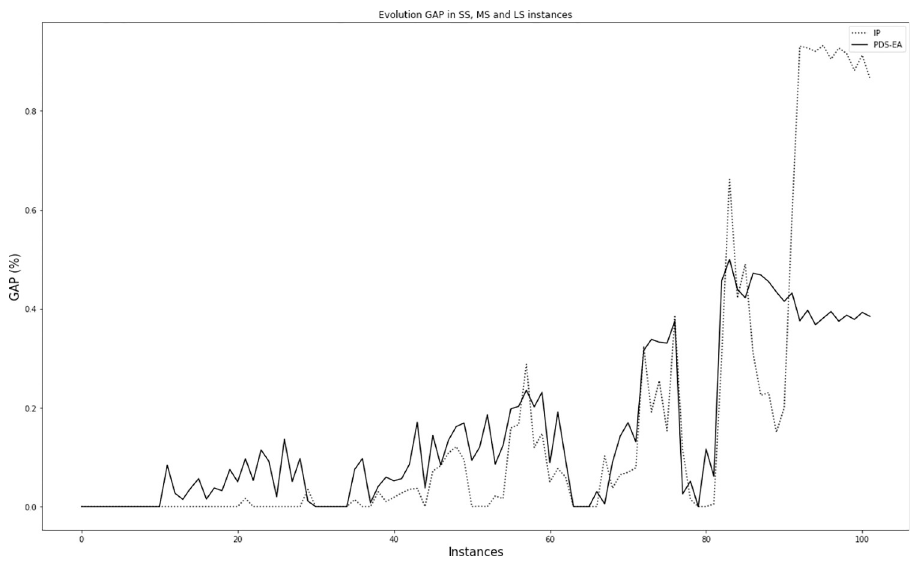
Fig 6. Gap for PDS-EA and IP for all instances ordered by the number of operations.